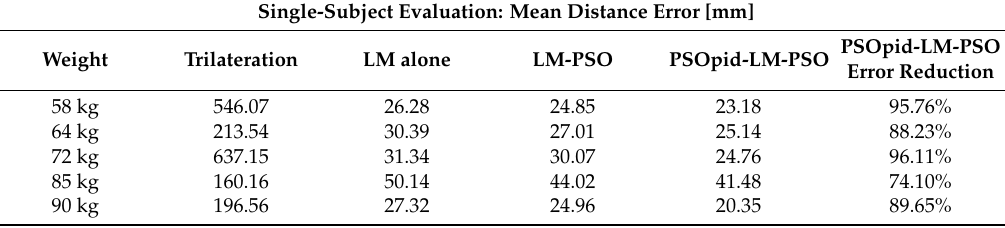
Table 3. Comparison results of the algorithm enhancement rates (out of 100 independent